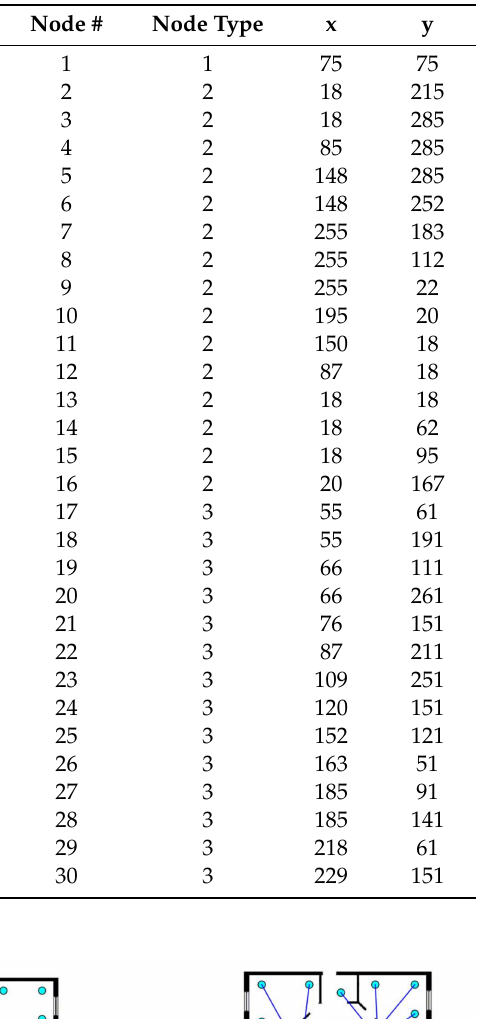
Table 2. Nodes of the synthesized network using the proposed approach for case study